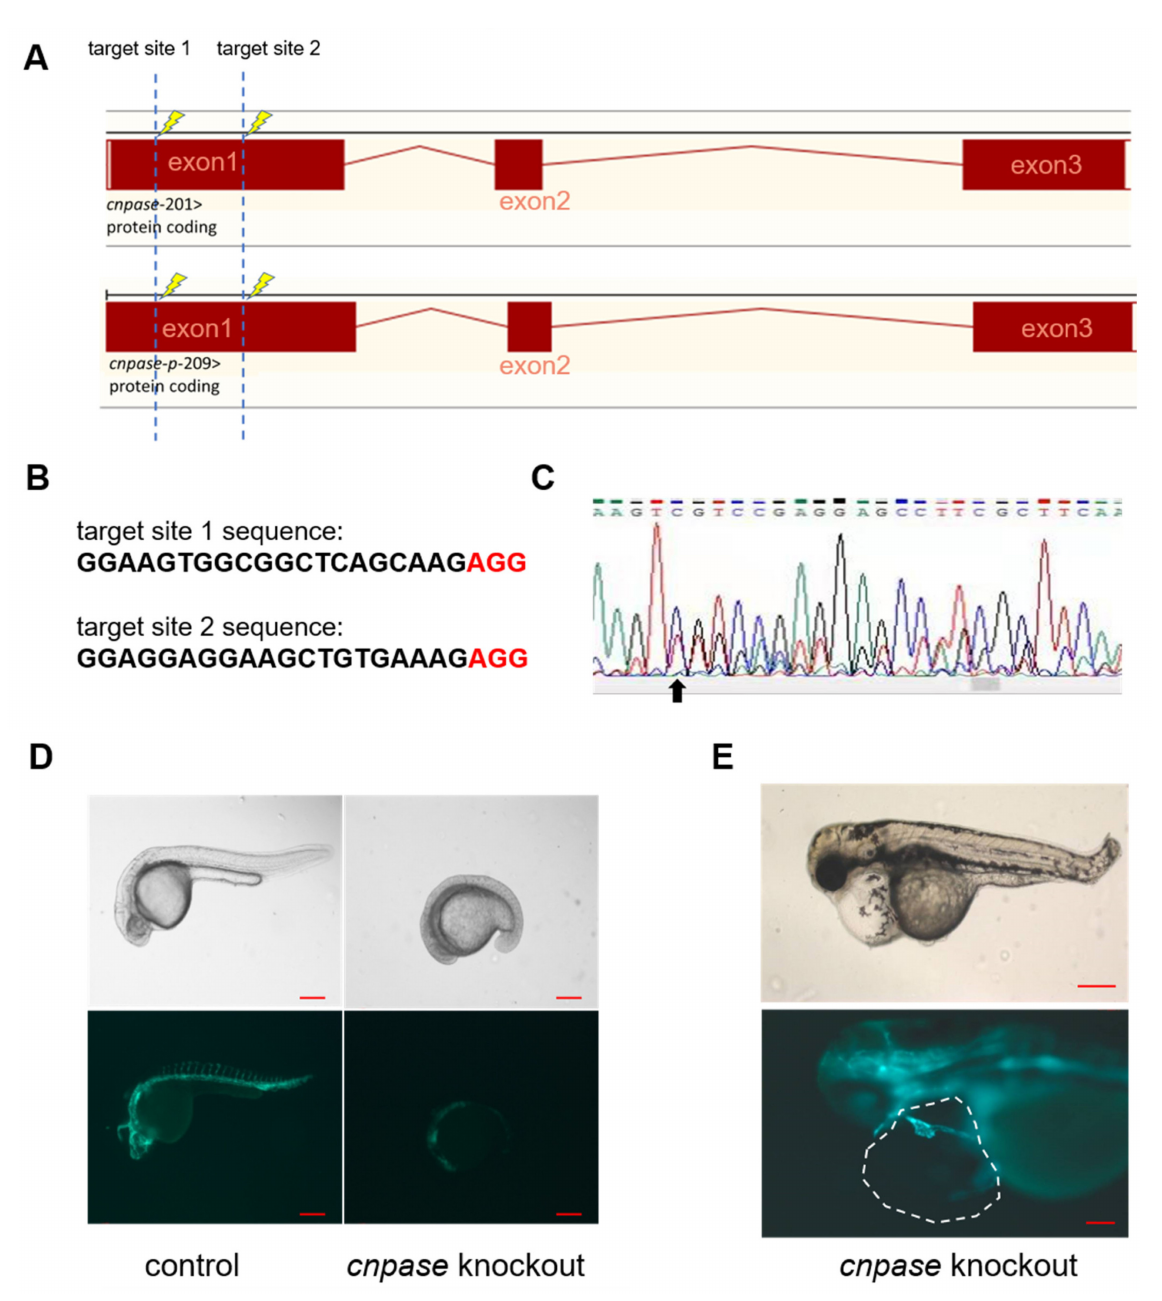
Figure 2. Generation of CNPase knockout zebrafish strain using the CRISPR-Cas9 editing system. ( A ) Schematic representa- tion of the knockout strategy using CRISPR-Cas9 by targeting the first exon of cnpase . The cnpase-201, cnpase-209 encodes CNPase I (45 kDa) and CNPase II (47 kDa), respectively. ( B ) Sequences of the target site 1 and 2. “AGG” is the protospacer adjacent motif. ( C ) The genotyping of cnpase+/ − zebrafish confirmed by tail-DNA PCR amplicons. The arrow indicates where the frame shift begins. ( D , E ) The cnpase deficient zebrafish exhibits developmental retardation, and cardiac failure phenotypes. Scale bar, 1000 µ